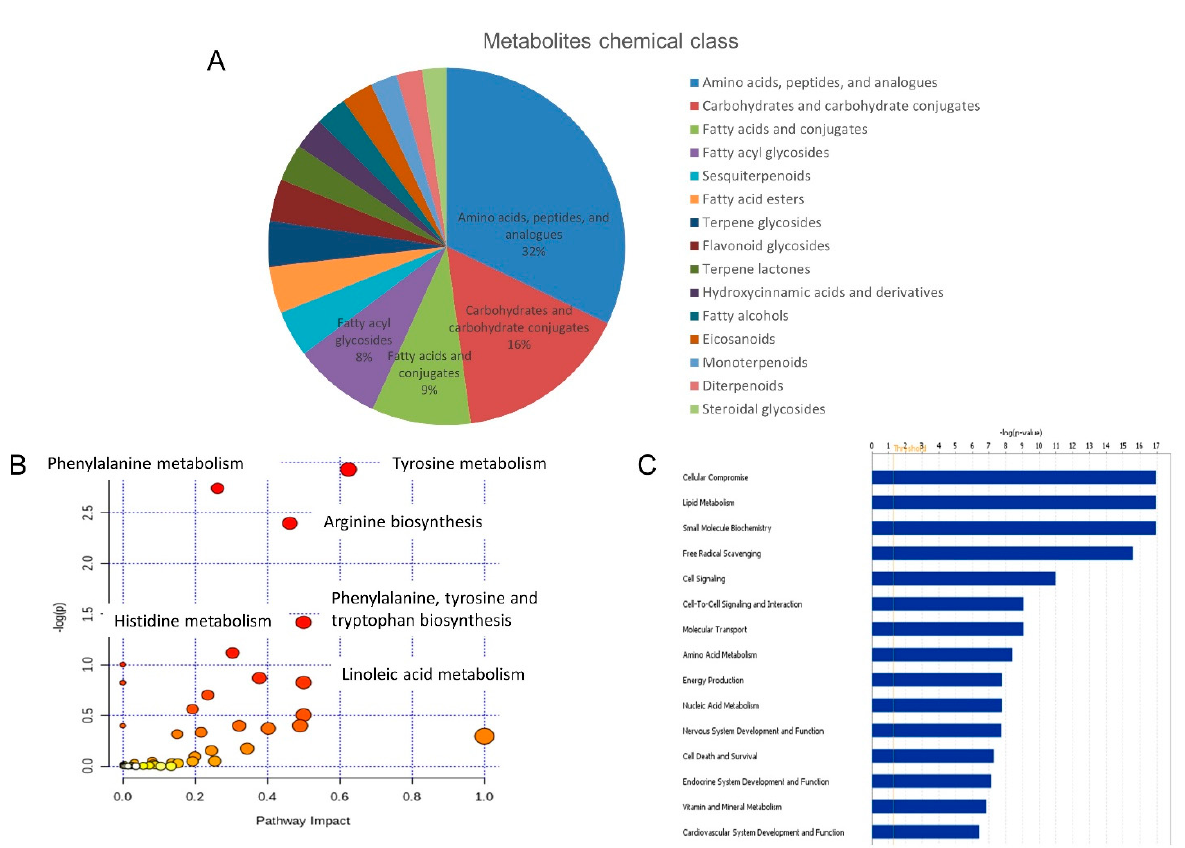
Figure 2. Urine metabolome profile analysis. ( A ) Chemical class of the identified metabolites. ( B ) Pathway analysis of the identified metabolites. ( C ) Functional annotation of the identified metabo- lites.